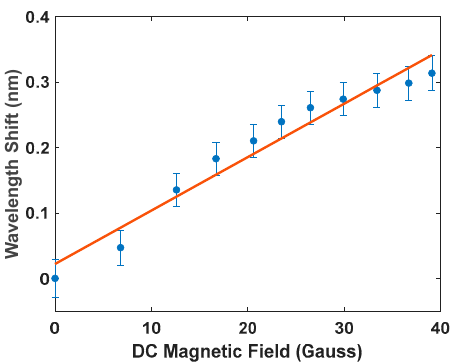
Figure 4. The experimental data for the DC magnetic-field measurement. The regression error is ~25 pm.